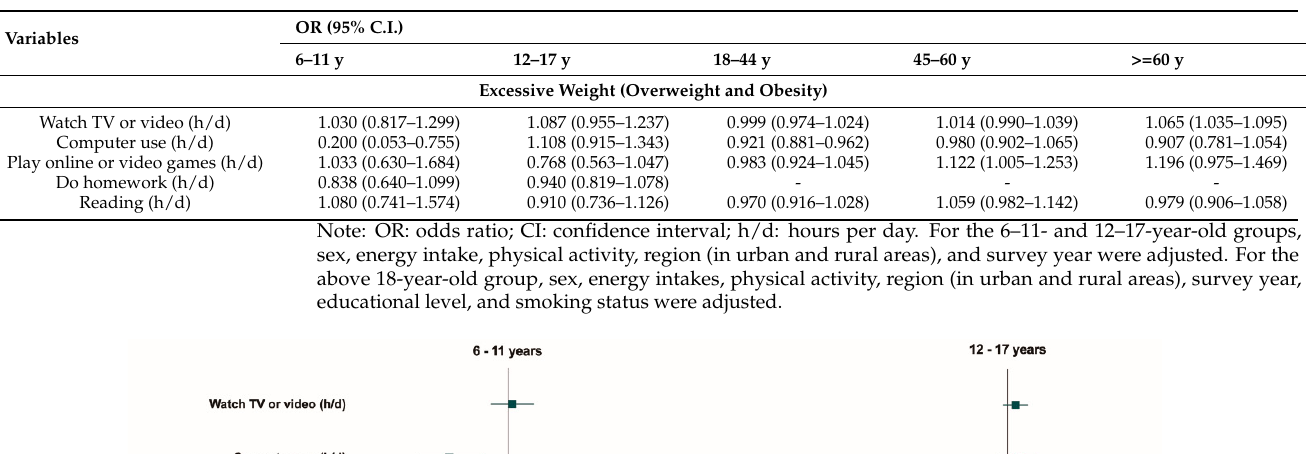
Table 1. Association between leisure-time sedentary behaviors and excessive weight among the Chinese population, CHNS 2004-2011.